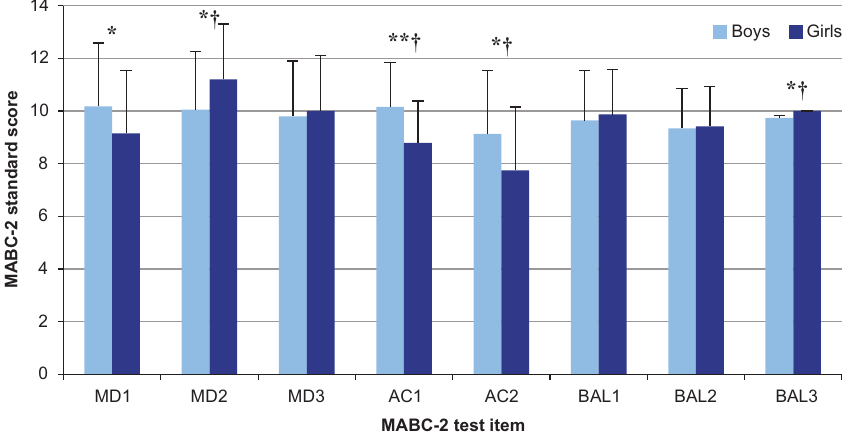
Figure 4. Comparison of the means of eight motor tasks of the MABC-2 be- tween preschool boys and girls. MD = manual dexterity; AC = aiming and catching;